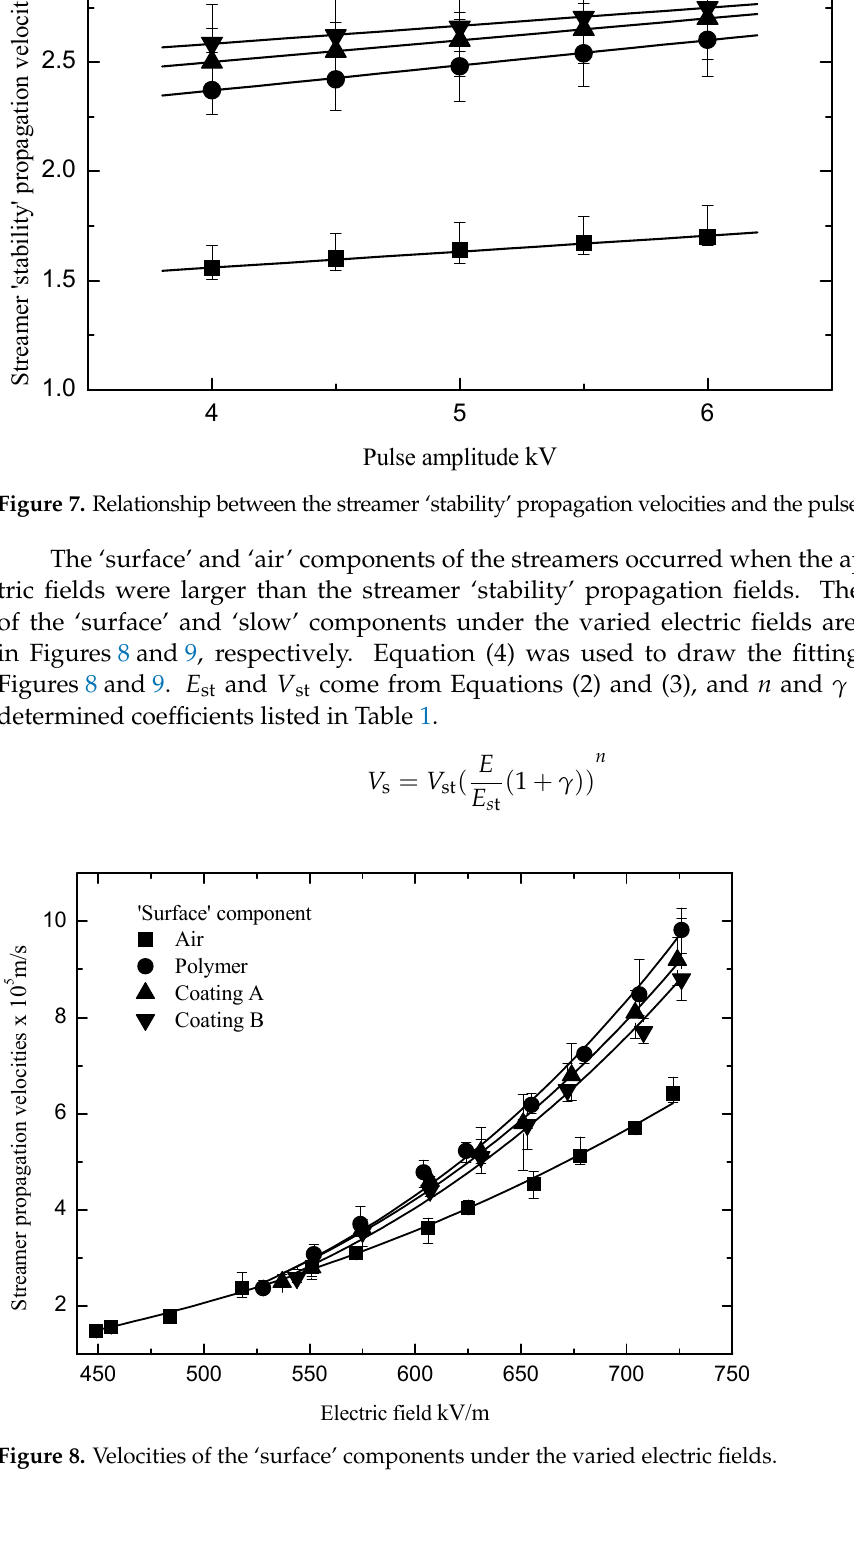
listed in Table 1.